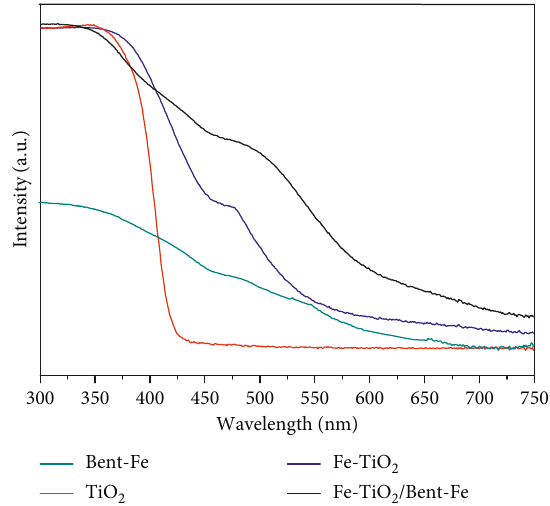
Figure 3: UV-Vis absorption spectra of the synthesized TiO Fe, Fe-TiO 2 , and Fe-TiO 2 /Bent-Fe materials.